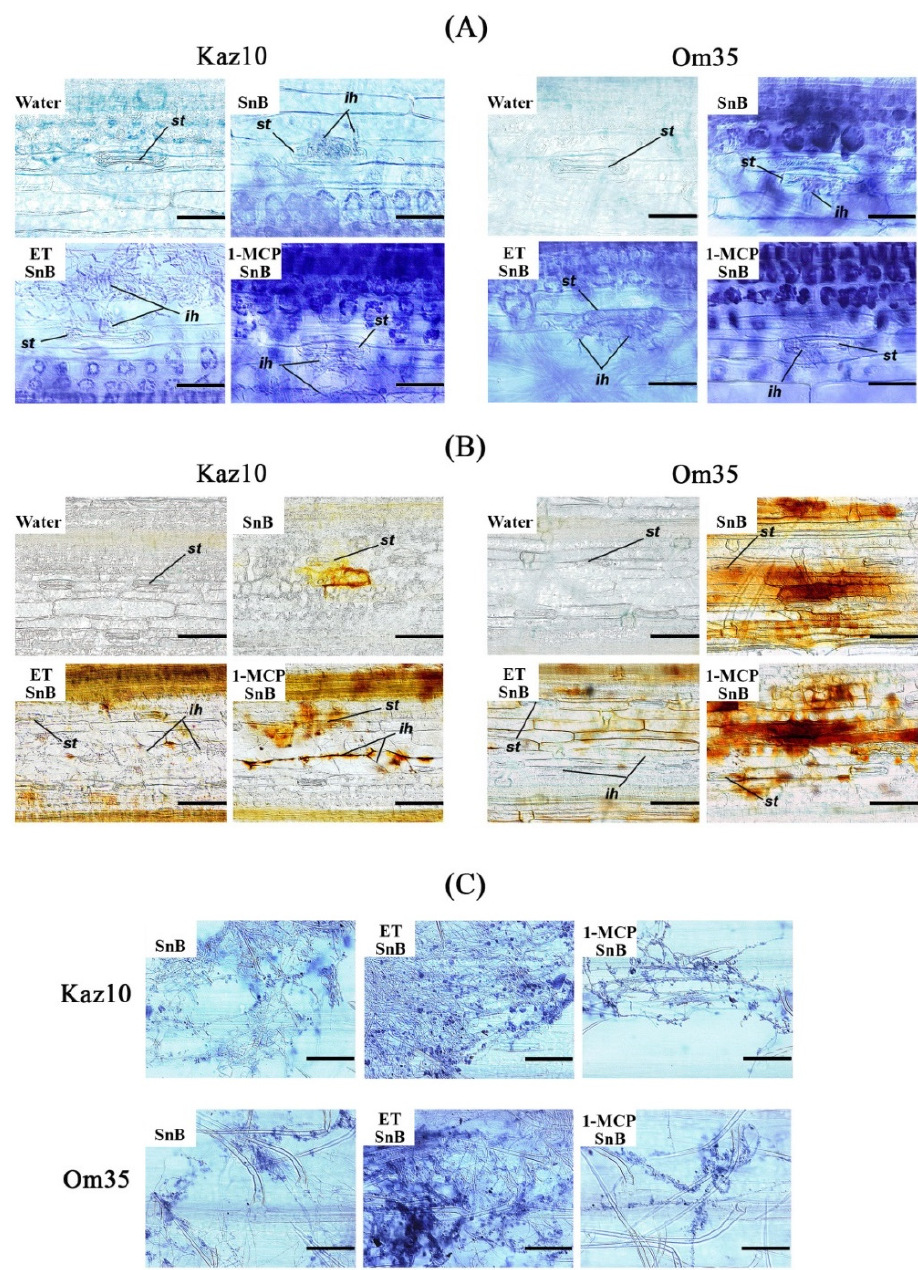
Figure 4. The effect of pretreatment with ethephone (ET) and 1-MCP on local generation of superoxide radical and H 2 O 2 and growth of pathogen mycelium in leaves of Kaz10 and Om35 wheat cultivars infected with SnB. ( A ) Superoxide radical accumulation in infected leaves of Kaz10 and Om35 at 6 hpi detected with HBT staining. Bar = 50 µ m. ( B ) H 2 O 2 accumulation in infected leaves of Kaz10 and Om35 at 24 hpi detected with diaminobenzidine (DAB) staining. Bar = 100 µ m. ( C ) The development of the S. nodorum mycelium on the leaves of Kaz10 and Om35 at 24 hpi detected with aniline blue staining. Bar = 50 µ m. The variants are numbered as follows: water—noninfected plants; SnB—plants infected with the S. nodorum SnB; ETSnB—plants infected with S. nodorum SnB, treated with ethephone (ET); 1-MCPSnB—plants infected with S. nodorum SnB, treated with 1-methylcyclopropene (1-MCP). Photographs represent results of a typical variant from a series of experiments (n = 10). ih —infections hyphae; st —stomata.